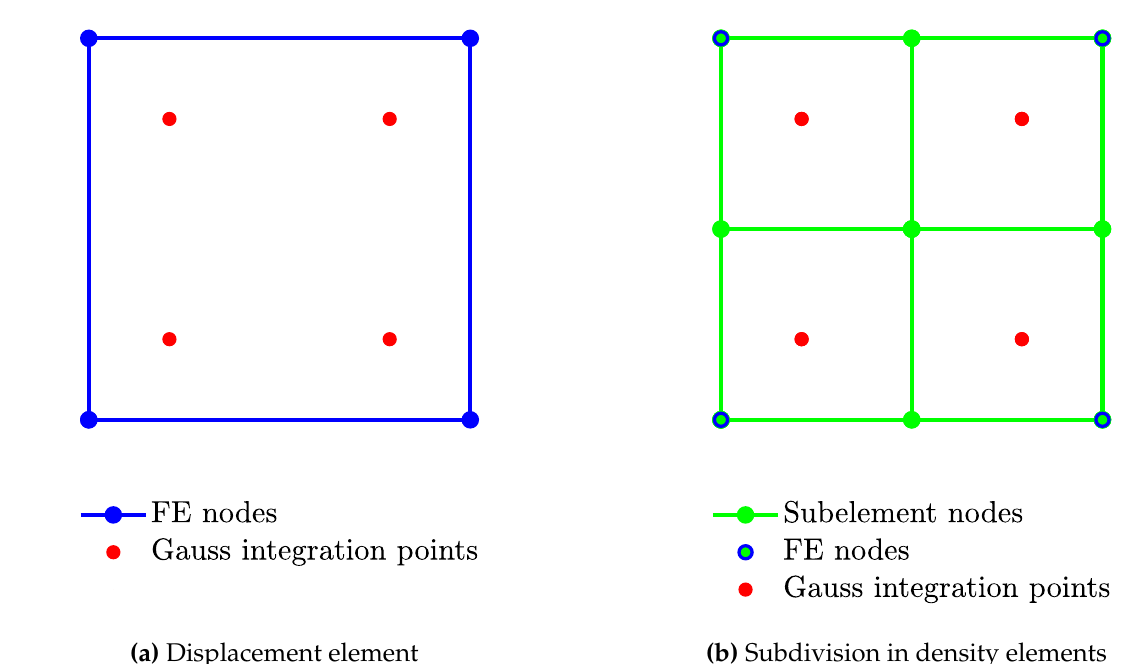
Figure 1. Example of displacement element and density elements for multiresolution topology optimization with four Gauss integration points